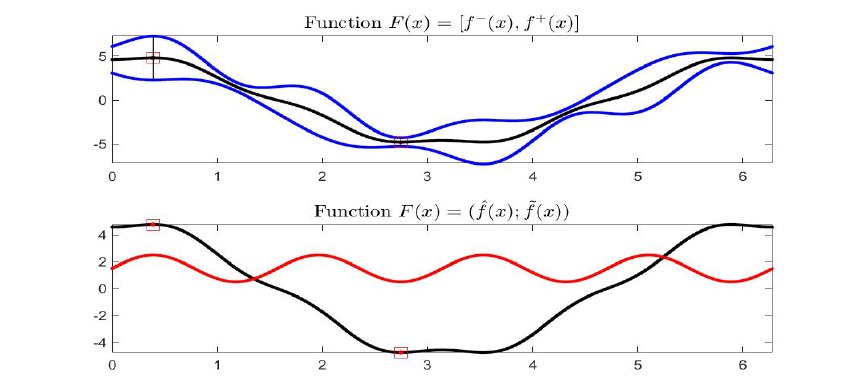
Figure 21. Periodic Example 2 (Siamese fishes): function F ( x ) is pictured on top and functions (cid:98) f ( x ) , (cid:101) f ( x ) on bottom . Marked points correspond to x m and x M , where the two functions are differentiable.